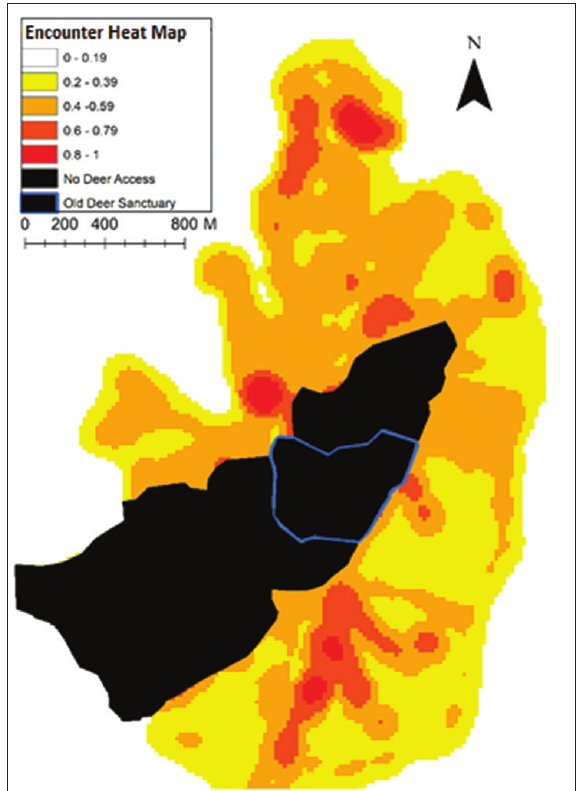
Figure 6. Modelled probability of human-deer ( Cervus elaphus ) encounters based on landscape features. Spatial grain= 20 m. The darker the colour, the greater the probability of encounters occurring. The hatched area is currently not accessible by deer but was included for the mapping of the spatial model. Area outlined in blue is an old deer refuge area that may be reopened in future. Data collected from Lyme Park, Disley, UK, in